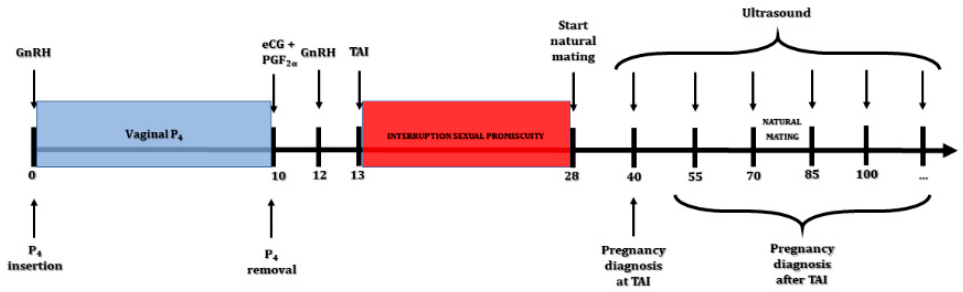
Figure 1. Synchronization treatment and experimental design during the study. TAI was carried out by the same experienced veterinarian using frozen and thawed semen of one buffalo